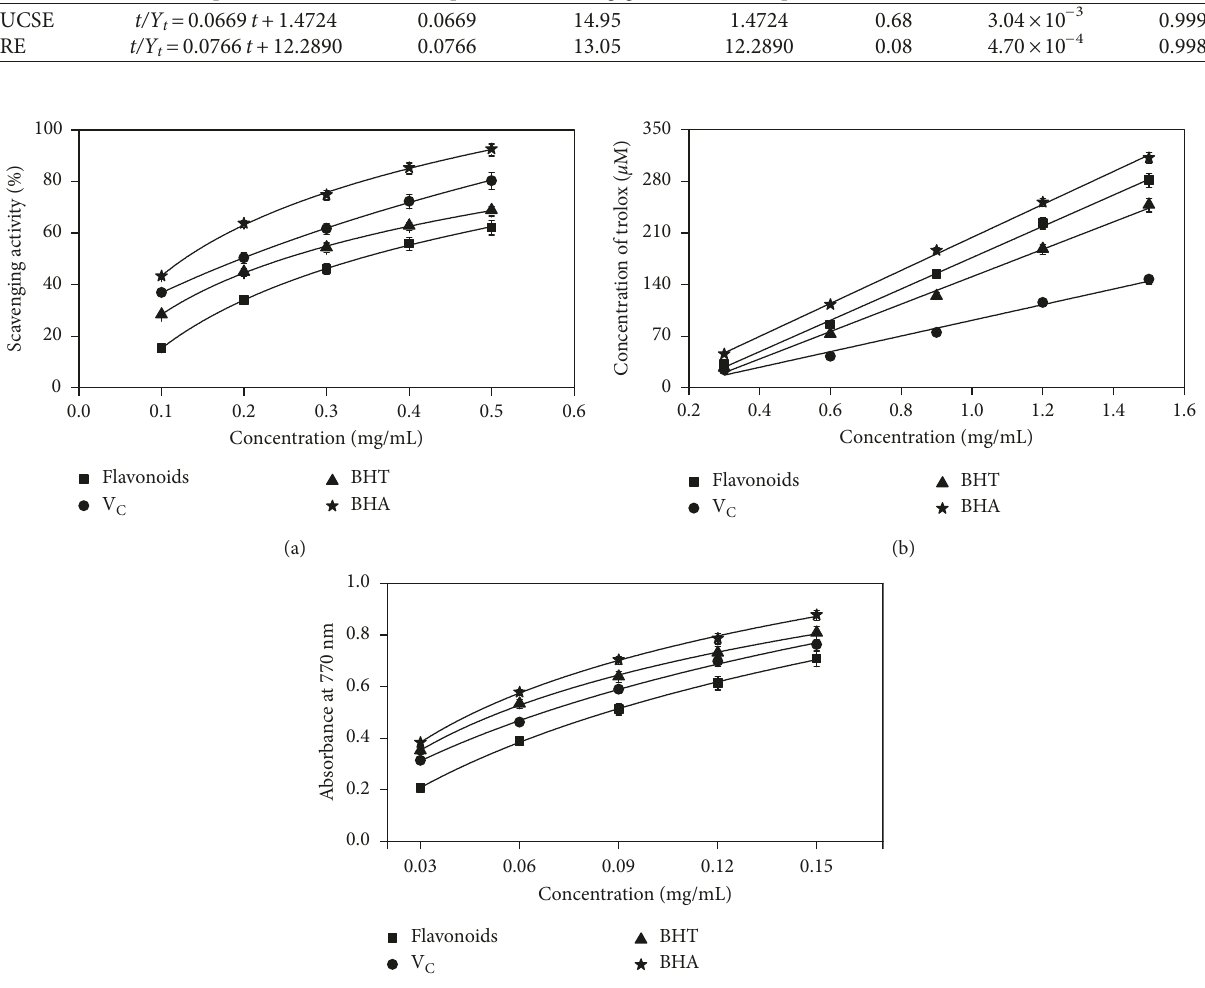
Figure 3: Second-order kinetics curves of HUCSE (a) and HRE (b). Table 3: Linearization of second-order kinetic model for C. camphora flavonoids extraction obtained by HUCSE and HRE. Method